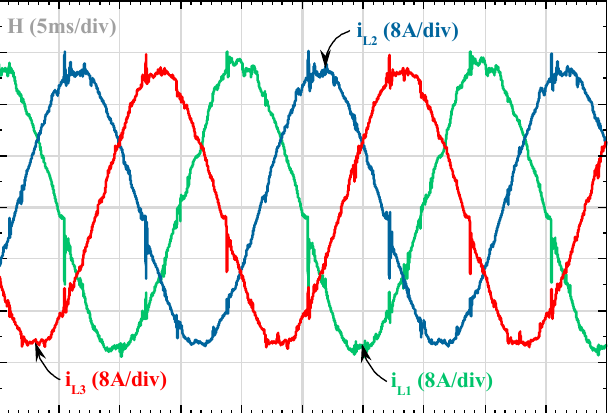
Figure 25. Experimental waveforms of the V IENNA rectifier with 800 V battery voltage and full load ( P ac = 11 kW).